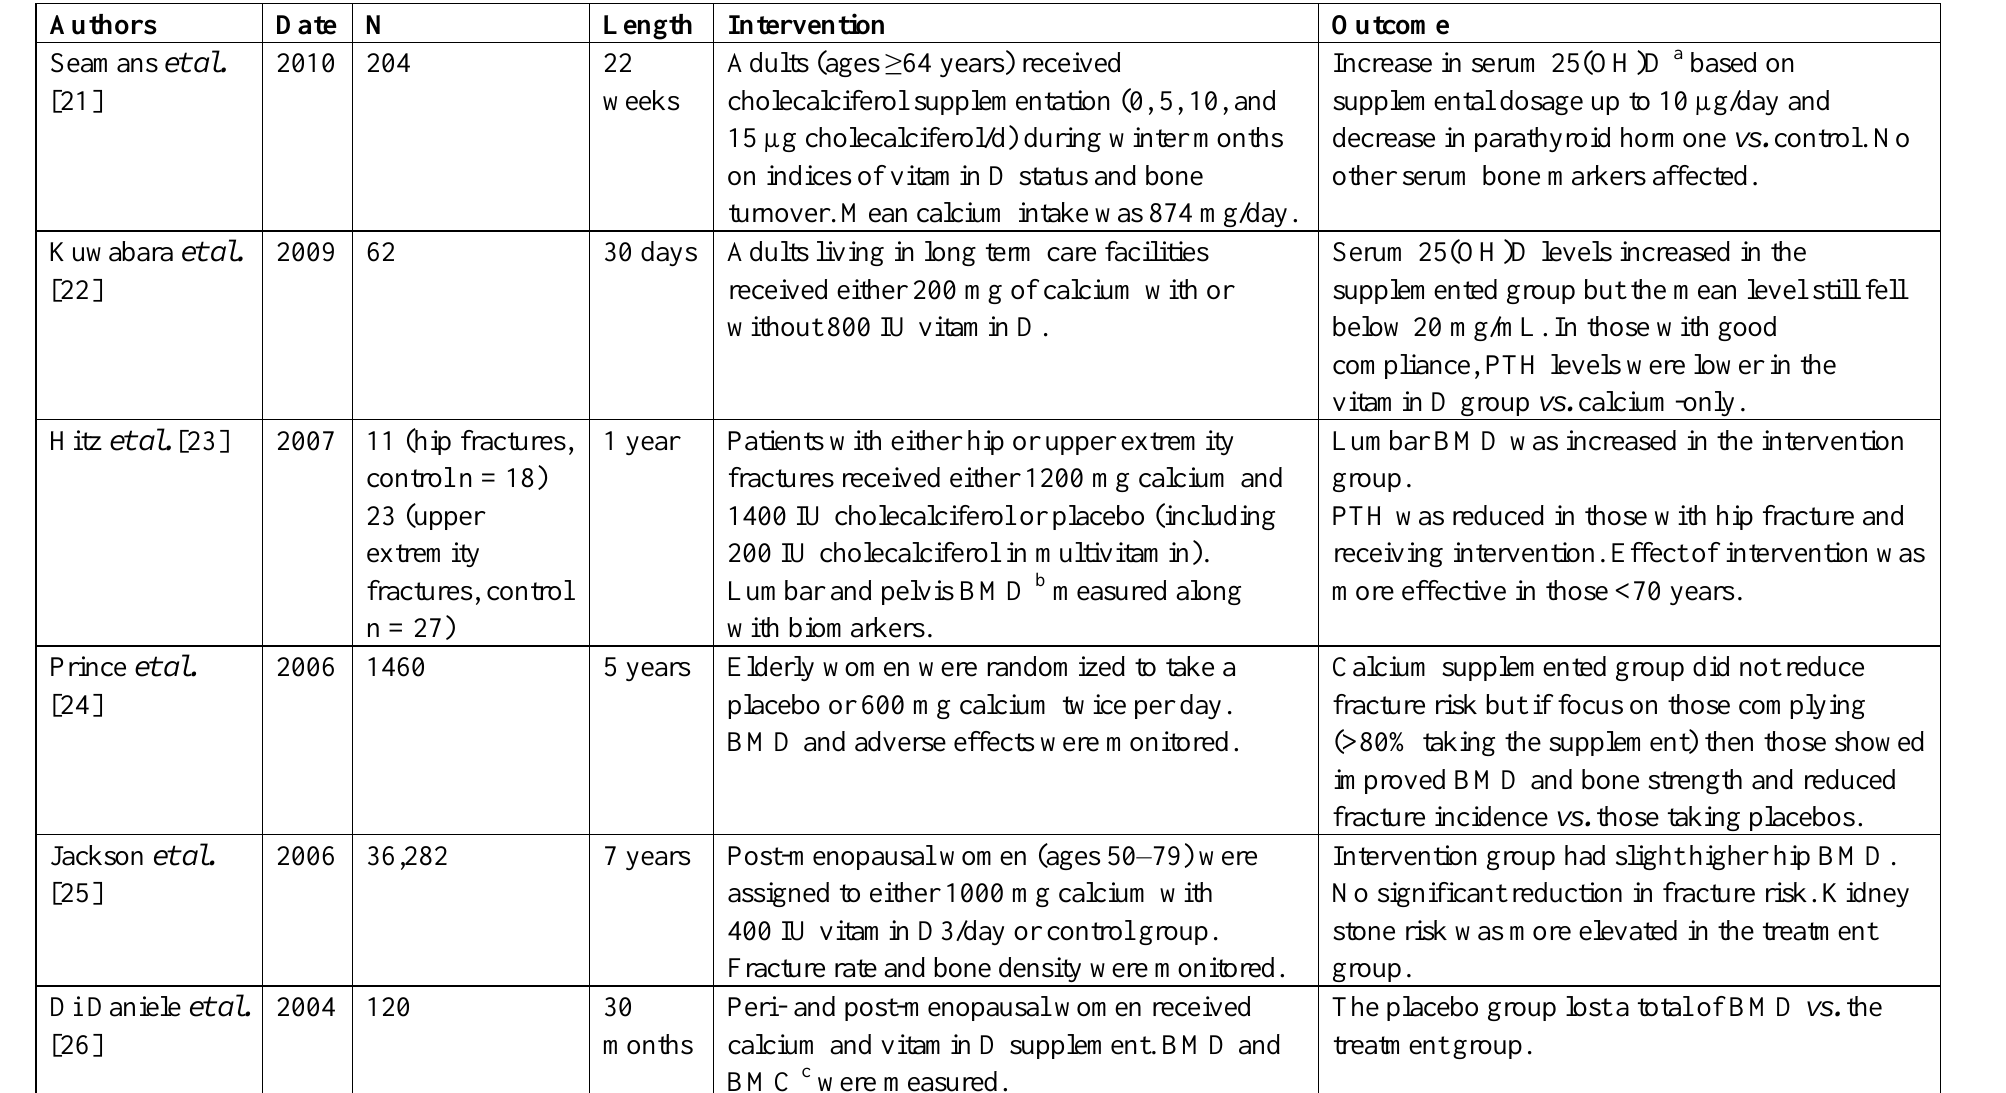
Table 2. Calcium and vitamin D interventions